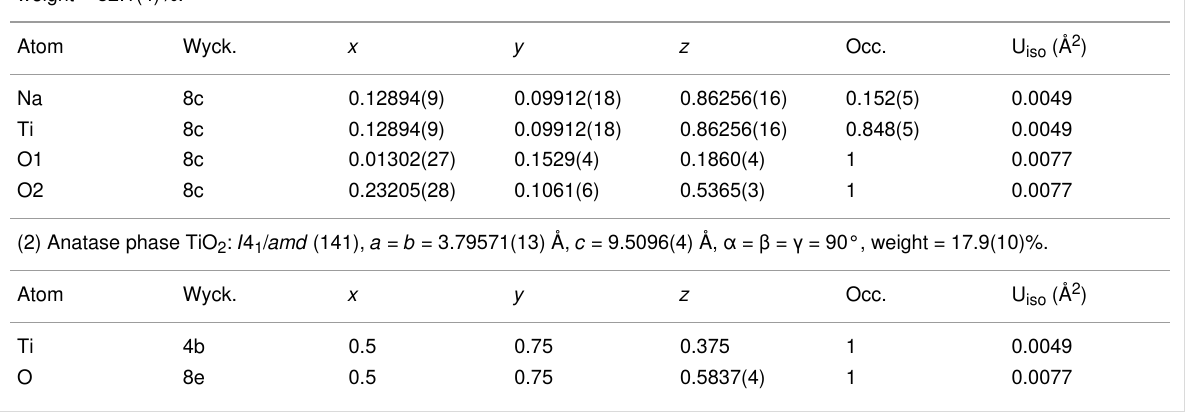
Table 2: Atomic coordinates and occupancies of the crystal structures of the brookite Na 0.152 Ti 0.848 O 2 and anatase TiO 2 phases in the sample calci- nated at 400 °C. The Rietveld R factors are R p = 3.31, R wp = 4.41, R exp = 2.82, and χ 2 =